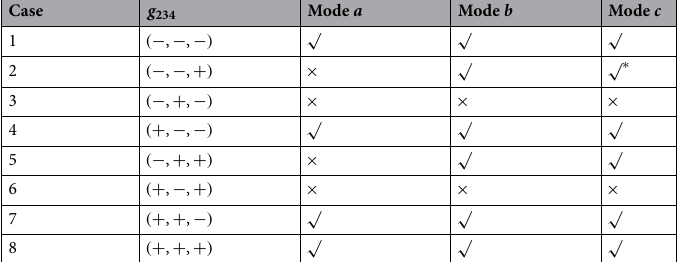
Table 3. Different predictions of the n th-order super- and sub-Poissonian statistics with n a ), phonon ( b ), and hybrid photon–phonon ( c ) modes, where g 234 is defined in Eq. (31). The photon ( z = cases marked with √ can be identified under both (1) nonresonance conditions, as shown in Fig. 14b, and (2) resonance conditions, as shown in Fig. 14a, except the case marked with ∗